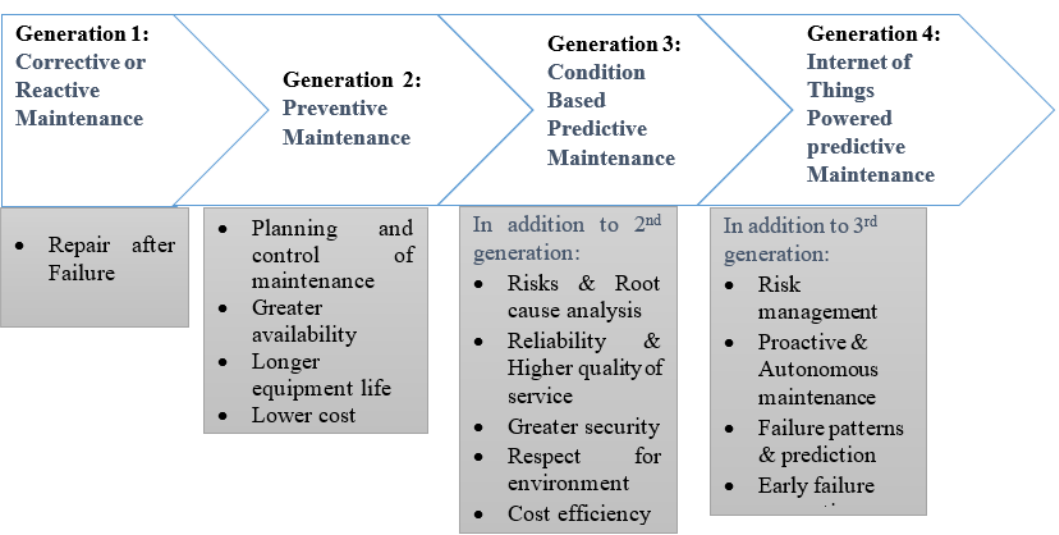
Figure 1. Industrial revolution maintenance techniques and